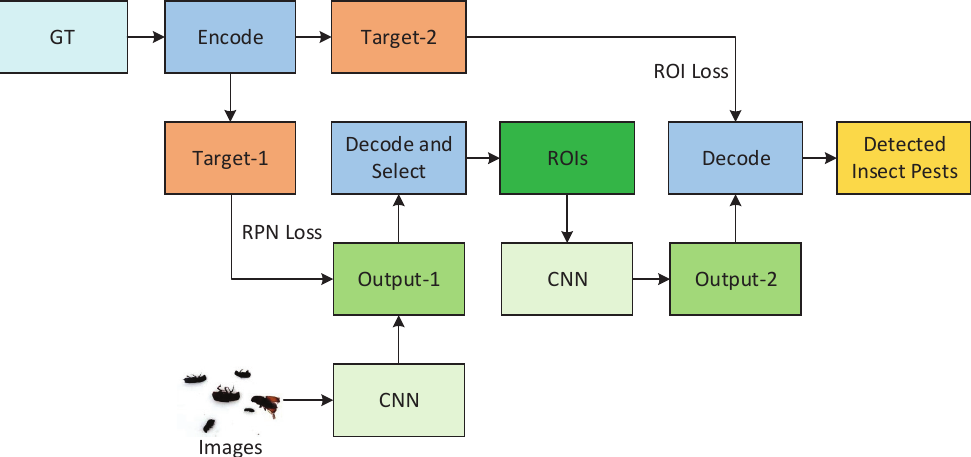
Figure 2. Flow chart of two-stage